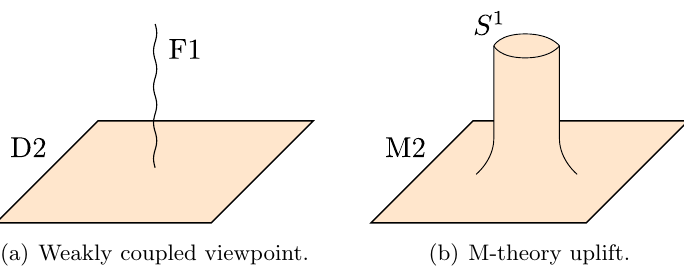
Figure 8 . A fundamental string ending on a D2 brane lifts to a smooth funnel-like solution for the M2 brane in